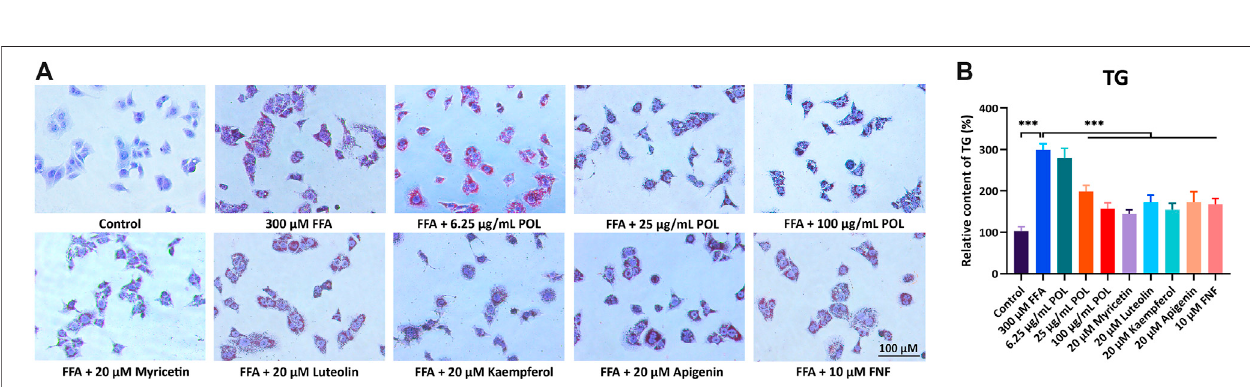
FIGURE 7 | The comparison of anti-lipid accumulation in different concentration of POL and four fl avonoids from POL. L02 cells were incubated with 300 μ M FFA (oleic acid: palmitic acid (cid:1) 2: 1) and treated with different concentrations of POL and 20 μ M myricetin, luteolin, kaempferol, and apigenin for 24 h, respectively. Lipid accumulation and content of TG were evaluated by oil red O staining (A) and enzymatic colorimetric assay (B) . Comparing with model group, *** p < 0.001.